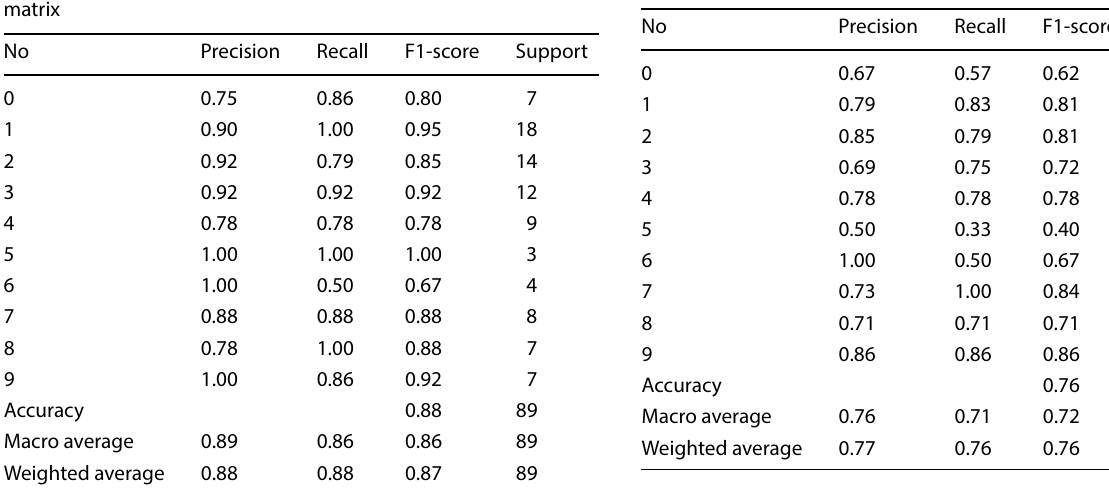
Table 5 Logistic regression (LR) result using the confusion